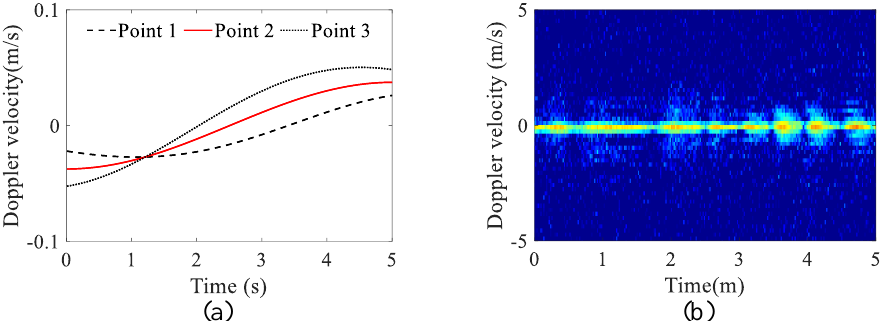
Figure 3. The theoretical micro-motion and the radar Doppler-time diagram of the vessel. ( a ) The theoretical velocity curves. ( b ) The simulated Doppler-time diagram of the